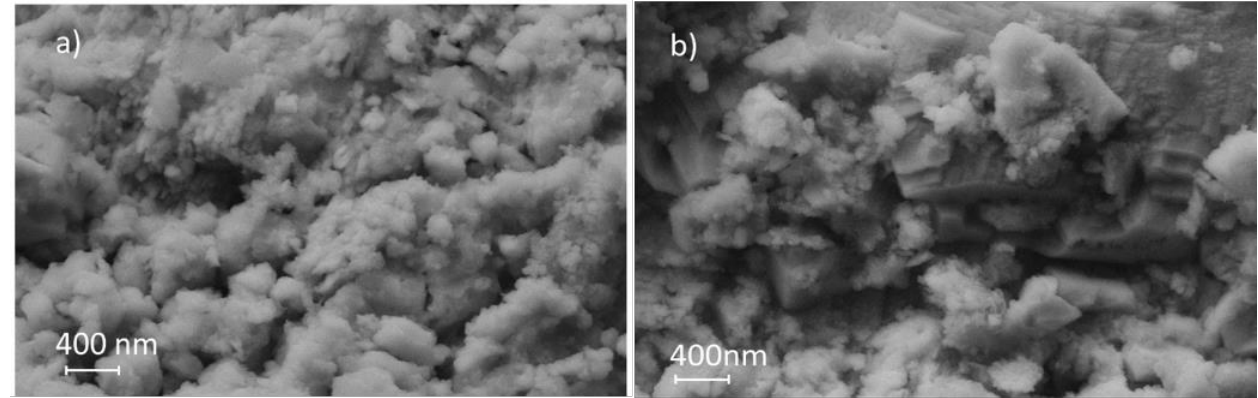
Figure 4. Field Emission Scanning Electron Microscope (FESEM) images of the slag-based geopolymer ( a ) GP (BFS, LS) and ( b ) GP (LD, BFS, LS).